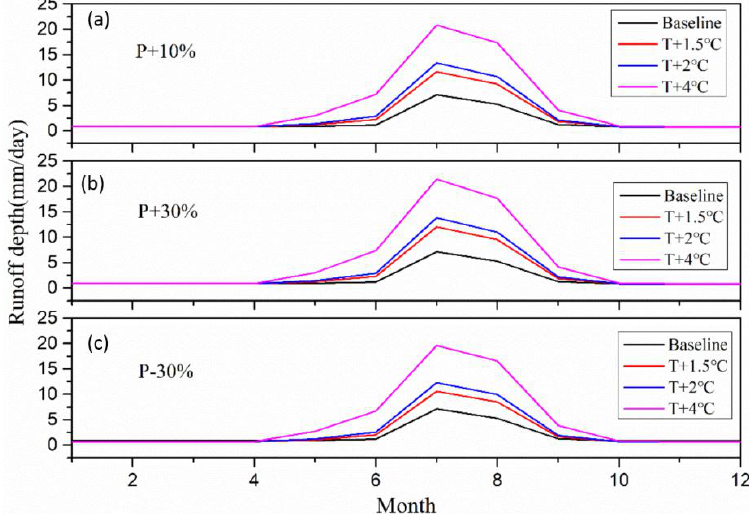
Figure 13. Compared with baseline, sensitivity analysis of runoff depth under combination of different precipitation and temperature change scenarios (1959–1961). ( a ) Precipitation increased by 10 % ( b ) Precipitation increased by 30 % ( c ) Precipitation decreased by 30 % Table 7. Runoff variation under different glacier area variation scenarios. (Area - 10% indicate glacier area decreased by 10%, Area - 53% indicate glacier area decreased by 53%, Area - 100% indicate glacier area decreased by 100%.)